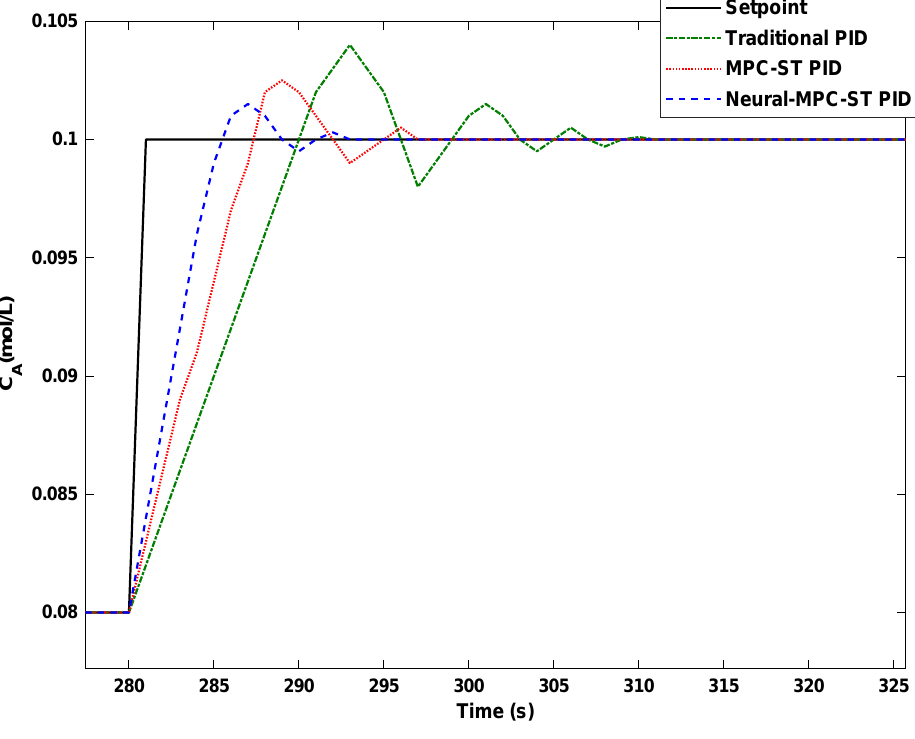
Figure 6. A closer look at a part of Figure